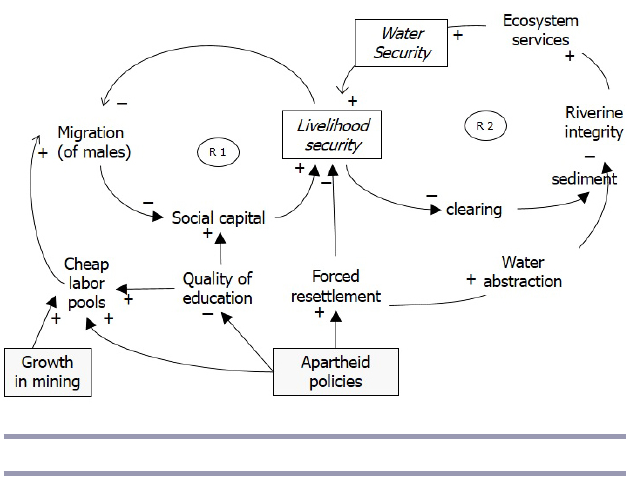
Fig. 2 . Causal–loop diagram exploring a systemic view of water security in the Sand River Catchment social-ecological system for the era 1950-1993.